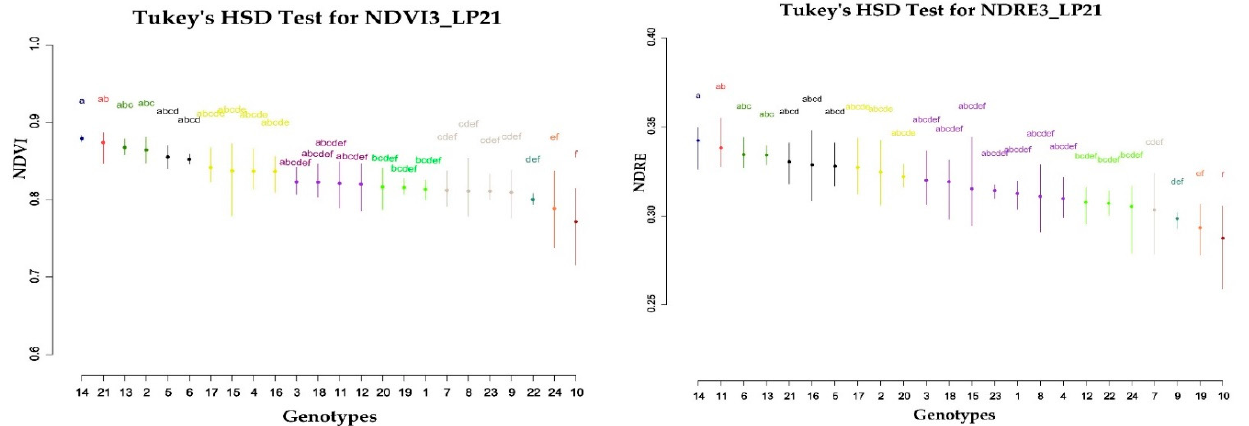
Figure 6. Tukey’s HSD separation procedure for NDVI and NDRE of the third monitoring date for the LP in 2021. Groups and range (genotypes with the same letter are not significant different).